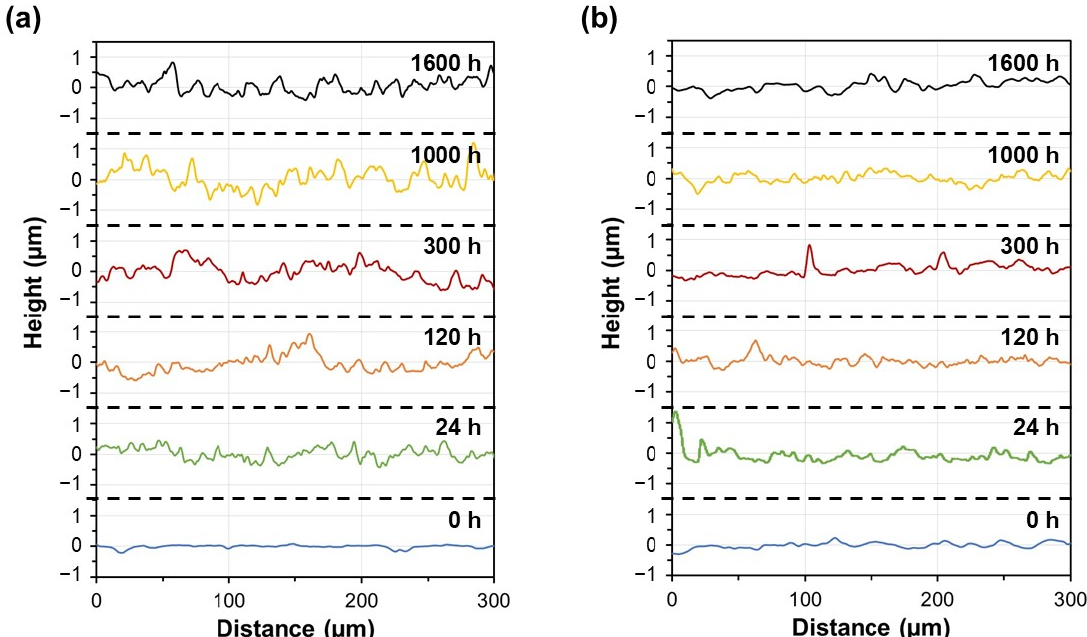
Figure 10. Surface topographic profiles of the oxide scales, obtained from contact profilometer, formed on the: ( a ) DS2205 and ( b ) DS2507, after exposing to molten salts for different times.